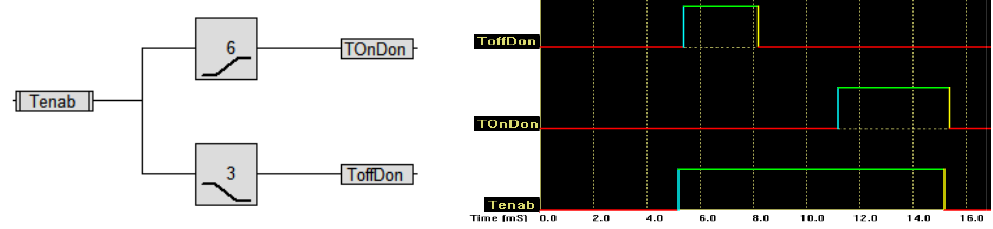
Figure 10. Example of Stateful primitives: delay timers, Ton, and Toff, with their behavior.